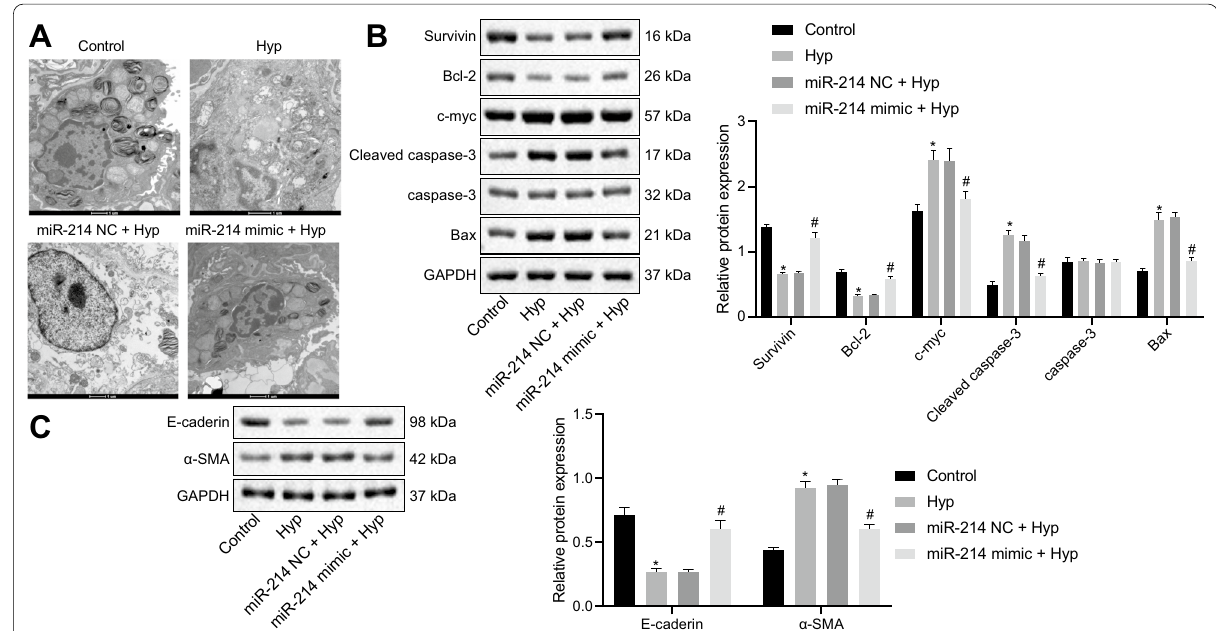
Fig. 4 miR‑214 overexpression suppresses apoptosis and fibrosis of embryonic pulmonary epithelial cells of rats with BPD. Hyperoxic pulmonary epithelial cells were transfected with miR‑214 NC or miR‑214 mimic. A The ultrastructure of alveolar epithelial cells under TEM ( 10,000). B × Western blot analysis for antiapoptotic proteins Survivin and Bcl‑2 and the proapoptotic proteins Bax, c‑myc, and cleaved caspase‑3 in embryonic pulmonary epithelial cells. C Western blot analysis for epithelial cell marker E‑cadherin and the fibrosis marker α‑SMA in embryonic pulmonary epithelial cells. The data are summarized as mean standard deviation. * p < 0.05 vs. pulmonary epithelial cells exposed to air. # p < 0.05 vs. hyperoxic ± pulmonary epithelial cells treated with miR‑214 NC. Multiple comparisons were performed using one‑way ANOVA, followed by Tukey’s post hoc test for multiple comparisons. Each experiment was repeated three